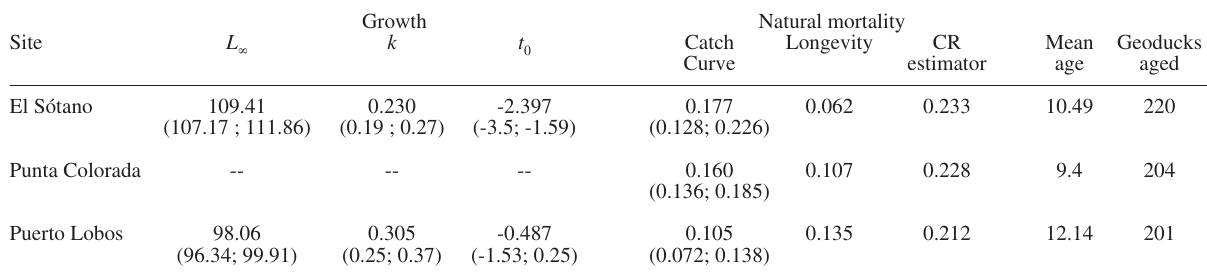
Table 1. – Parameters of the von Bertalanffy growth model and natural mortality estimation discriminated by location and method (mortality) (upper and lower confidence intervals are shown between brackets). Growth Natural mortality